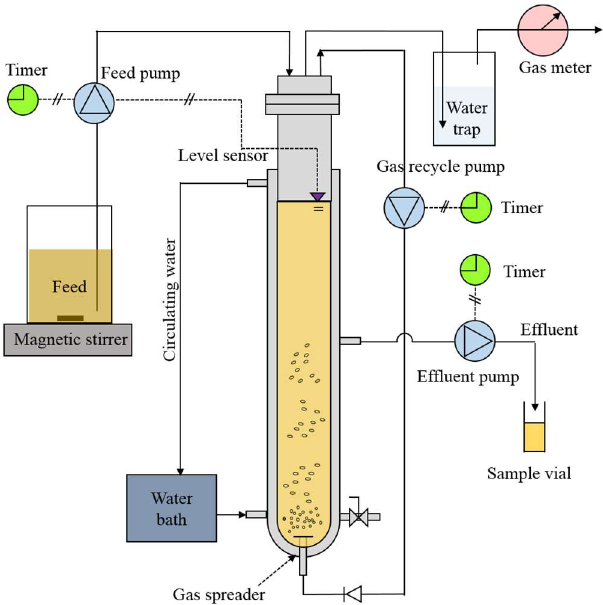
Figure 1. Schematic diagram of the anaerobic sequencing batch reactors (ASBR) used in this study with recycled biogas.